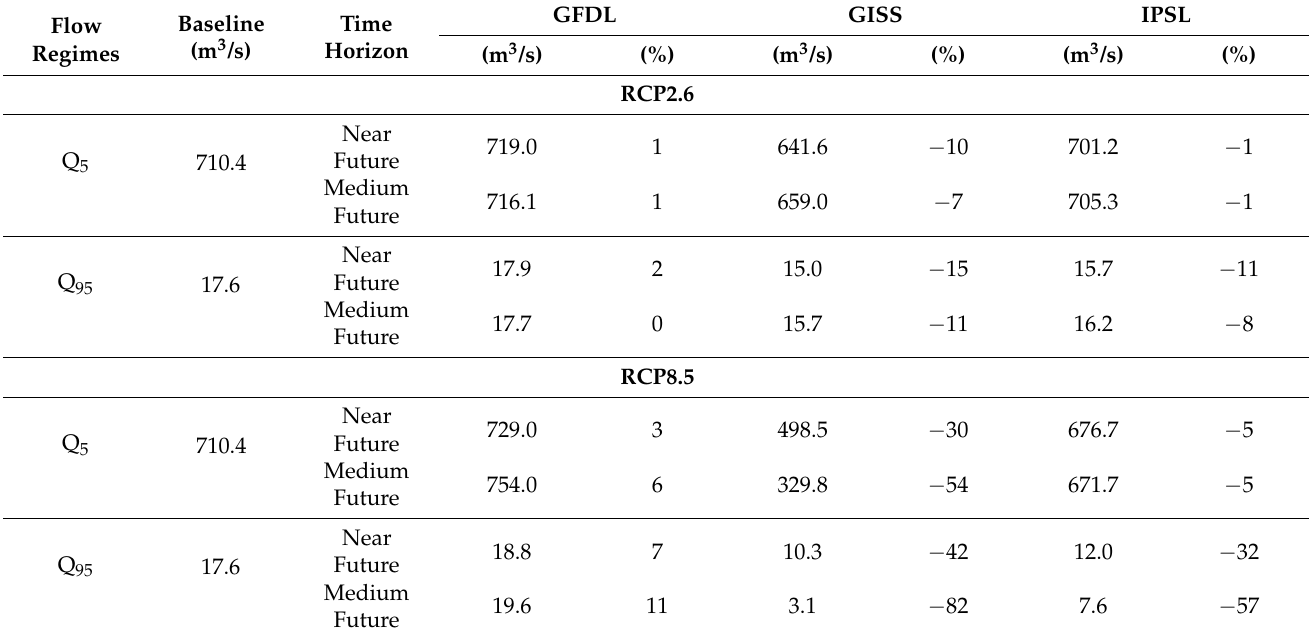
Table 10. Extreme flows and their percentage changes in the near future and medium future compared to the baseline period for the three GCMs under the RCP2.6 and RCP8.5